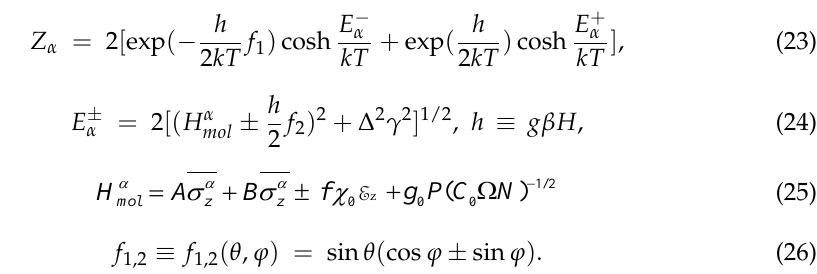
Figure 2. Dependence of the uniform polarization P , strain U , and magnetic moment M upon the angle between the external magnetic field and the crystal axis [100] in the antiferroelastic phase [20,21]. It is clear from Figure 2 that the electric polarization is linearly proportional to the magnetic field, while the homogeneous strain is quadratic in H according to the magne- tostriction of the nonmagnetic materials. Changing the angle θ from 90 ° to 180° changes the sign of the orthorhombic strain as the stabilized and inverted sublattices exchange